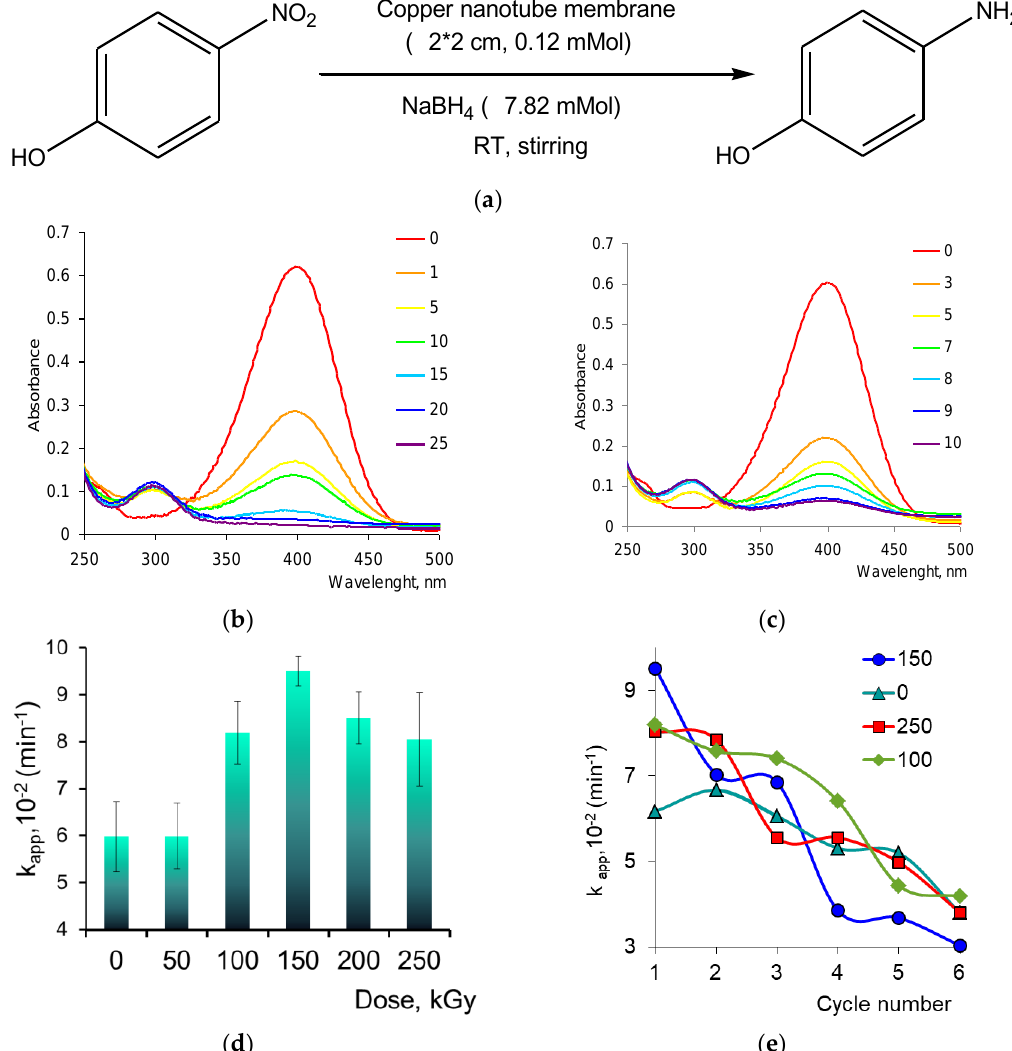
Figure 4. Scheme of the studied reaction of the p-nitrophenol reduction ( a ), typical time-dependent absorption spectra for the catalytic reduction of p-nitrophenol on the surface of the ( b ) pristine and ( c ) irradiated (150 kGy) Cu NTs composite membrane; the change of the rate constant for the ( d ) first run and ( e ) six consecutive test